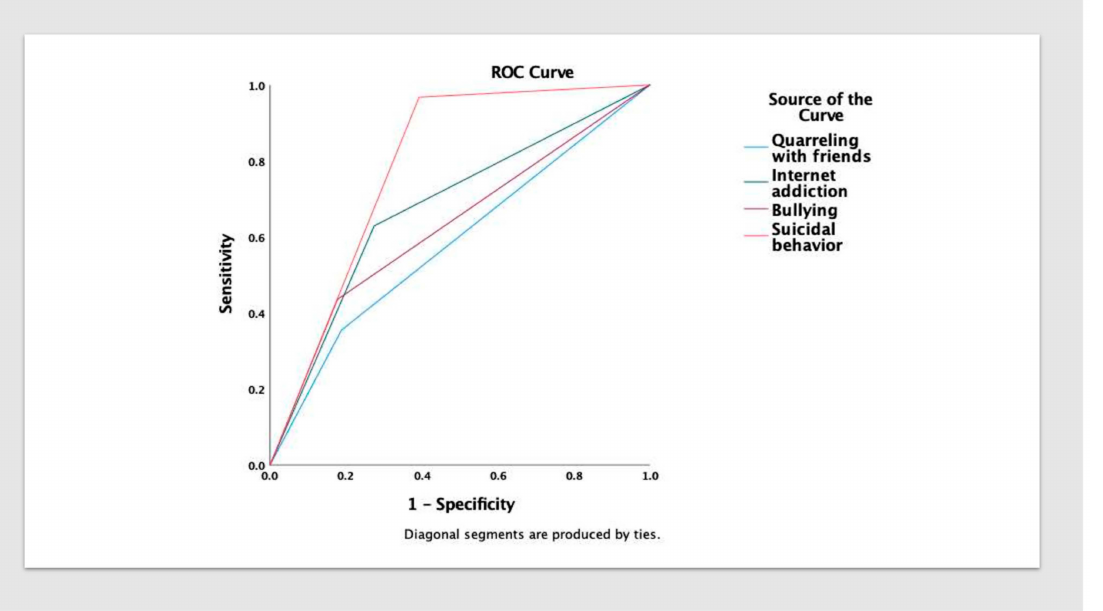
Figure 4. Area under the receiver operating characteristic curve (AUROC) for predicting suicide at- tempts in children and adolescents. Independently, suicidal behavior (0.79 (95% CI = 0.73–0.84), p < 0.001), internet addiction (0.68 (95% CI = 0.60–0.76), p < 0.001), and bullying (0.63 (95% CI = 0.55–0.71), p < 0.002) achieved the best